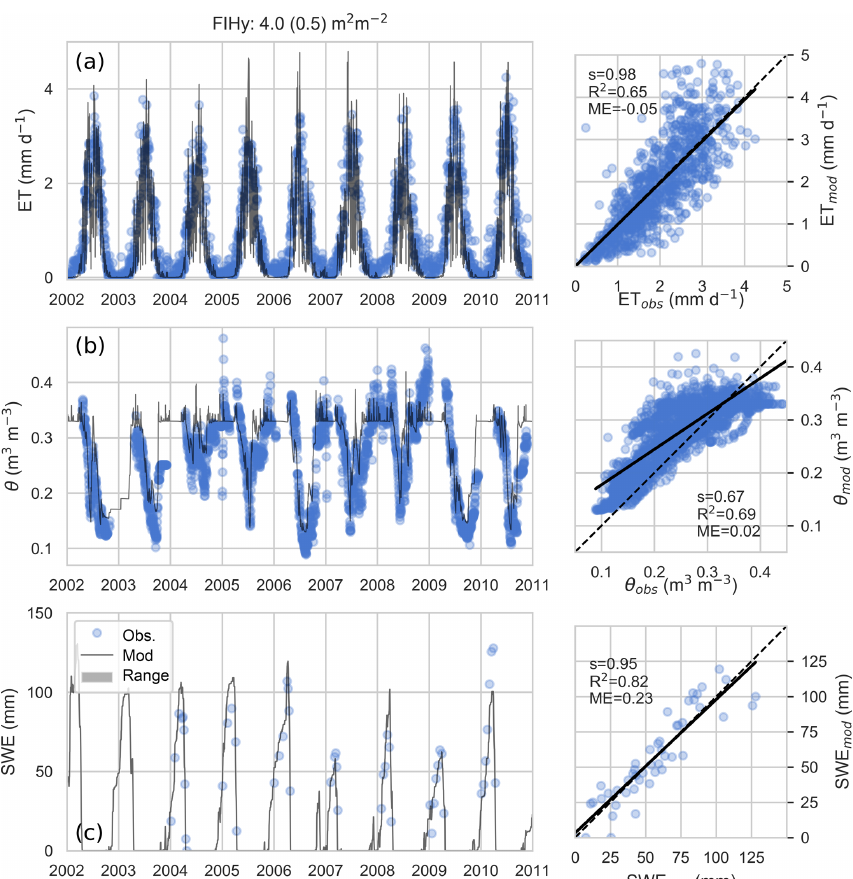
Figure 4. Modeled vs. measured dry-canopy ET at FIHy (a) , root zone water content θ (b) and snow water equivalent SWE (c) . As soil freezing is not modeled, comparison of θ is restricted to conditions when measured soil temperature was ≥ 0 ◦